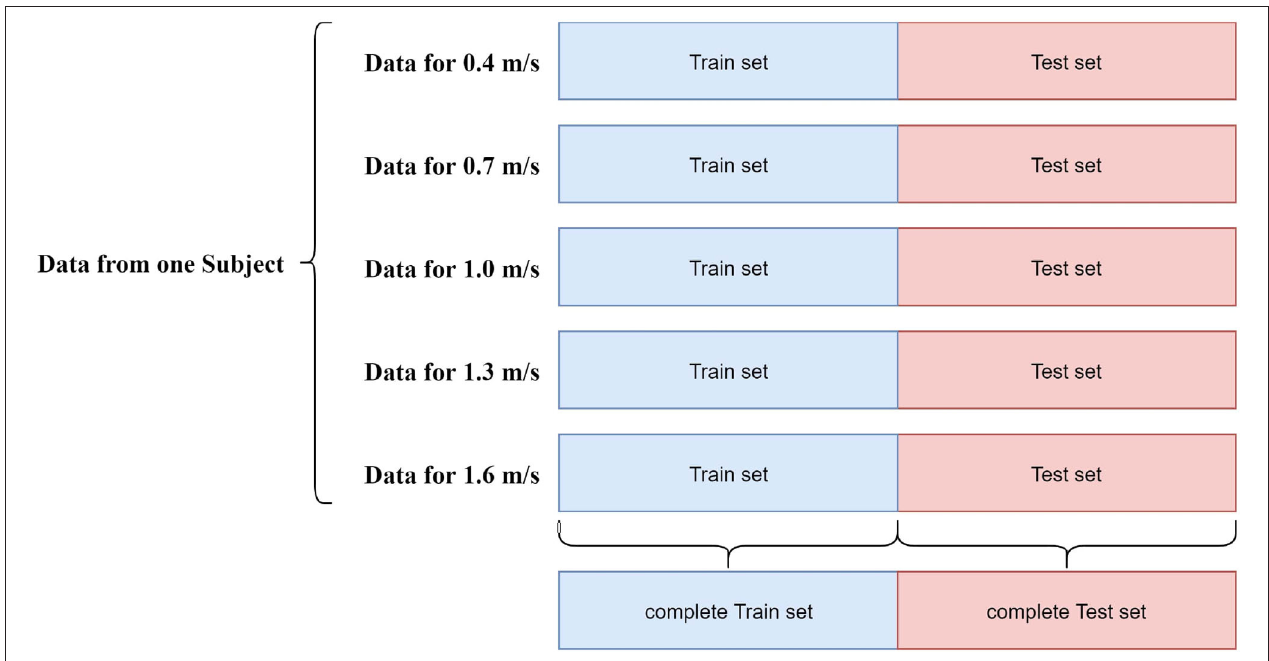
FIGURE 3 | Overview of the data splitting procedure.